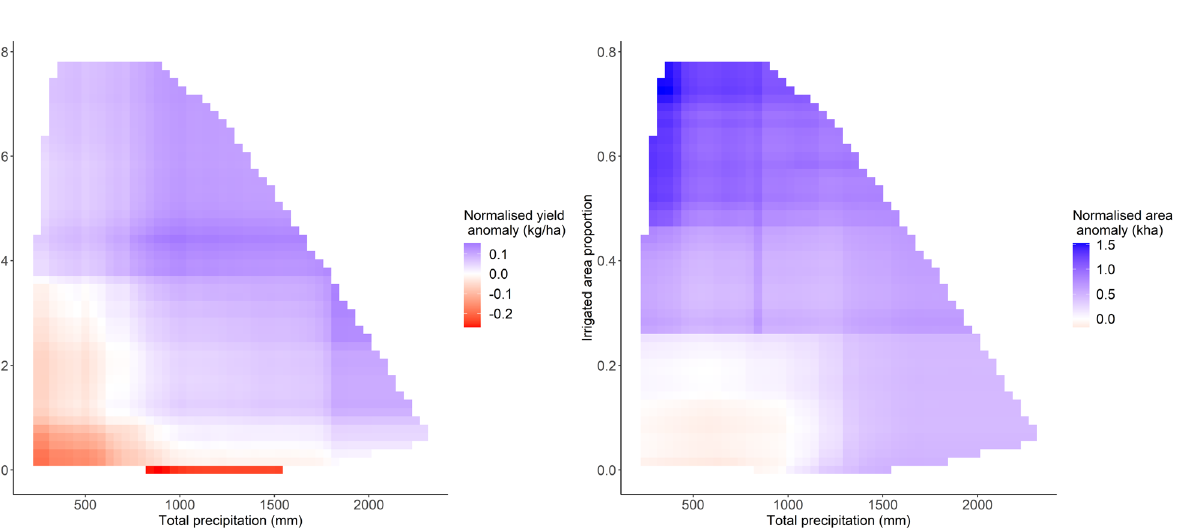
Figure 5. Partial dependence two-way interaction plots for the yield and harvested area response